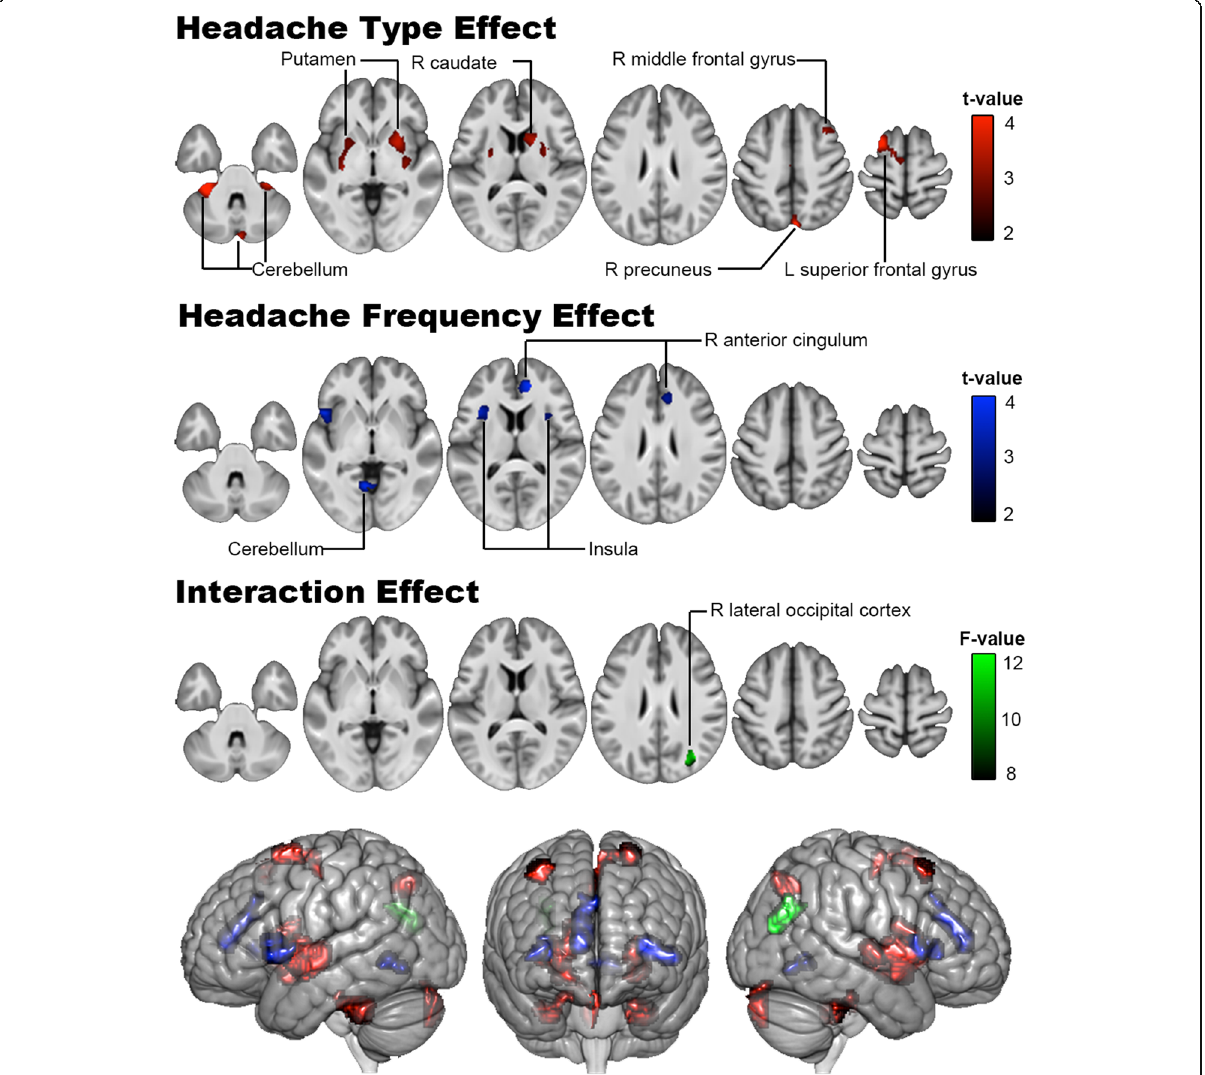
Fig. 2 Difference of gray matter volume between TTH and migraine. A 2 × 2 ANCOVA analysis was used to investigate the effects of headache types (TTH vs. migraine), headache frequency (episodic vs. chronic) and their interaction upon the gray matter volume difference between TTH and migraine. The brain regions with gray matter differences are color-coded in red (TTH > migraine), blue (episodic > chronic) and green (type × frequency interaction). L: left; MIG: migraine; R: right; TTH: tension-type